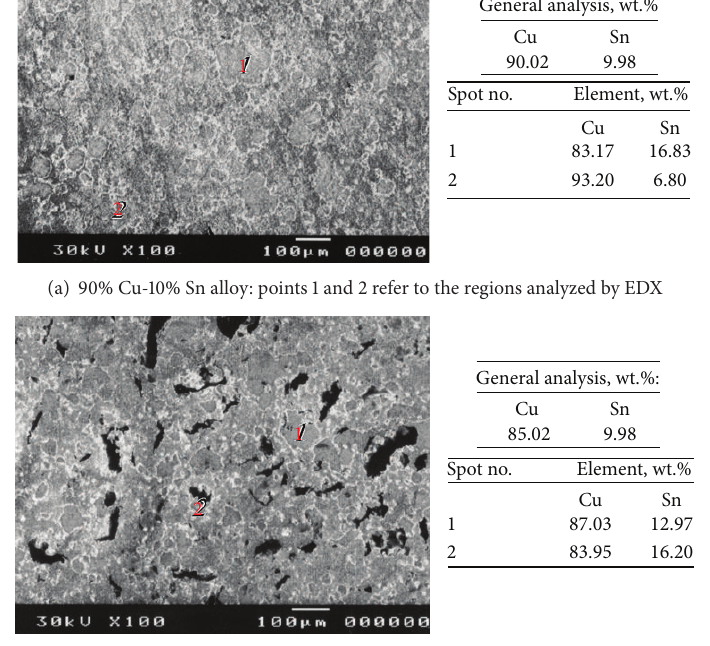
Figure 4: SEM micrographs and EDX analysis of heat-treated (a) 90% Cu-10% Sn and (b) 85% Cu-10% Sn-5% C alloys.